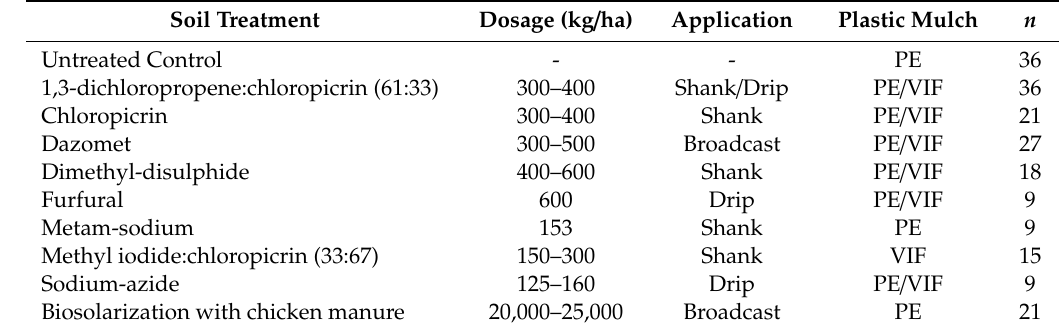
Table 2. Soil disinfestation treatments applied to a field naturally infested with Pratylenchus penetrans to determine their e ffi cacies in reducing soil nematode